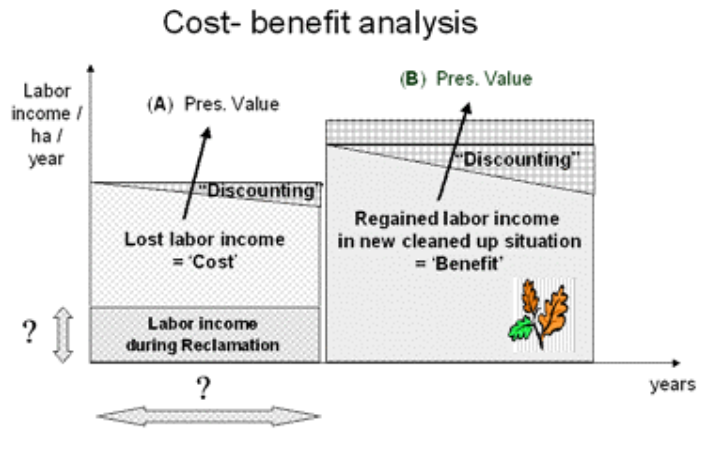
FIGURE 2 . The framework of cost-benefit